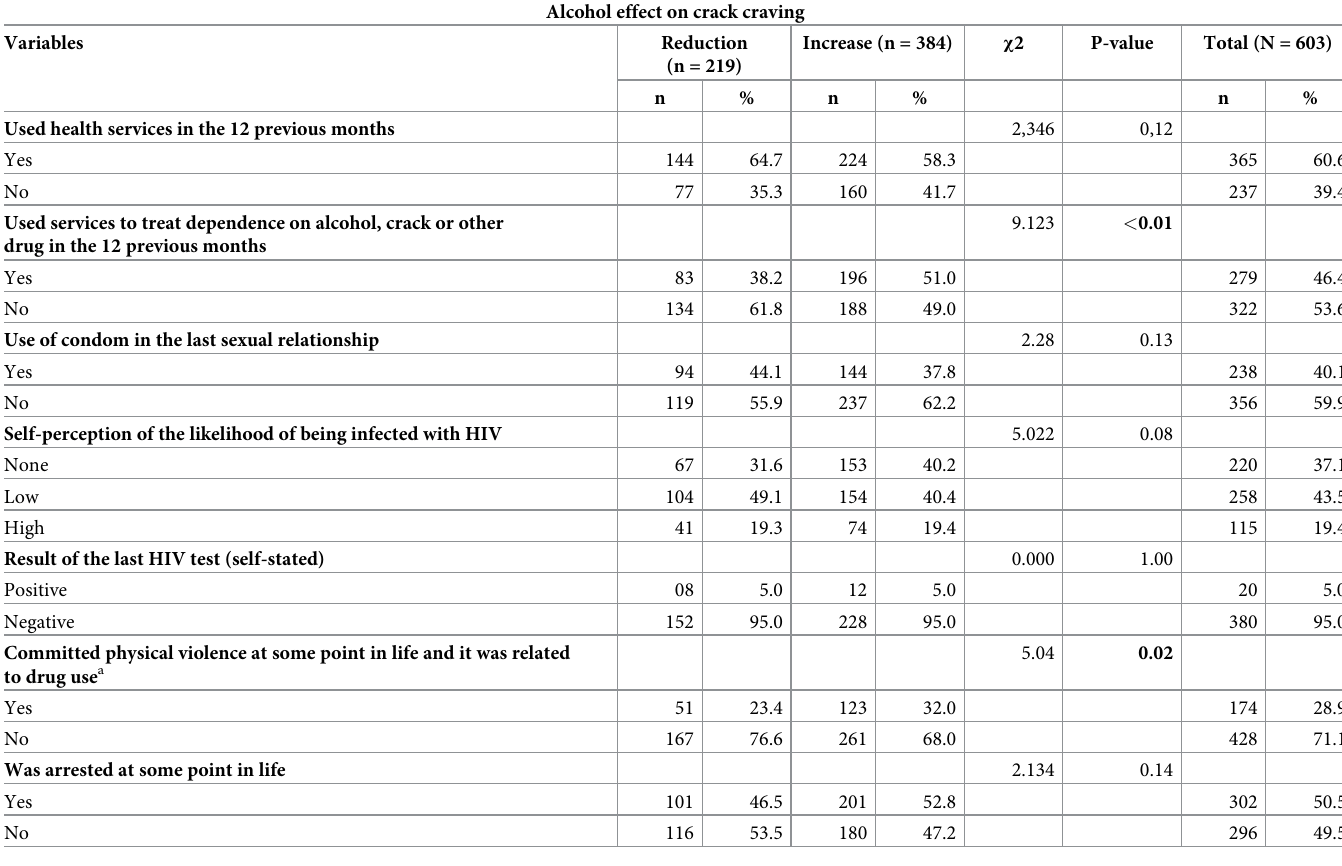
Table 3. Characteristics of the utilization of health and treatment services, sexual behavior, self-perception of the likelihood of being infected with HIV, violence and criminality among people who use crack assisted in the Atitude Program, Pernambuco, August 2014 to August